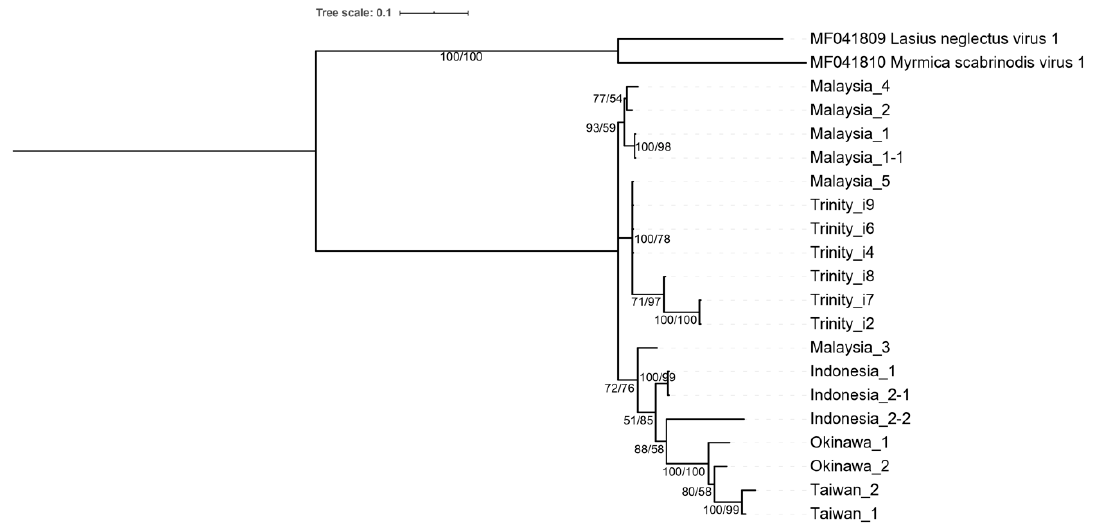
Figure 4. Phylogeny of Anoplolepis gracilipes virus 3 based on RdRp region. A total of 13 sequences obtained from field-collected colonies and six Trinity transcripts were included. The phylogenetic tree was constructed using both the maximum likelihood and Bayesian inference methods. The numbers at each node indicate the bootstrap supporting value and the posterior probability, respectively. The tree was rooted at the Lasius neglectus virus 1 and Myrmica scabrinodis virus 1 clade.